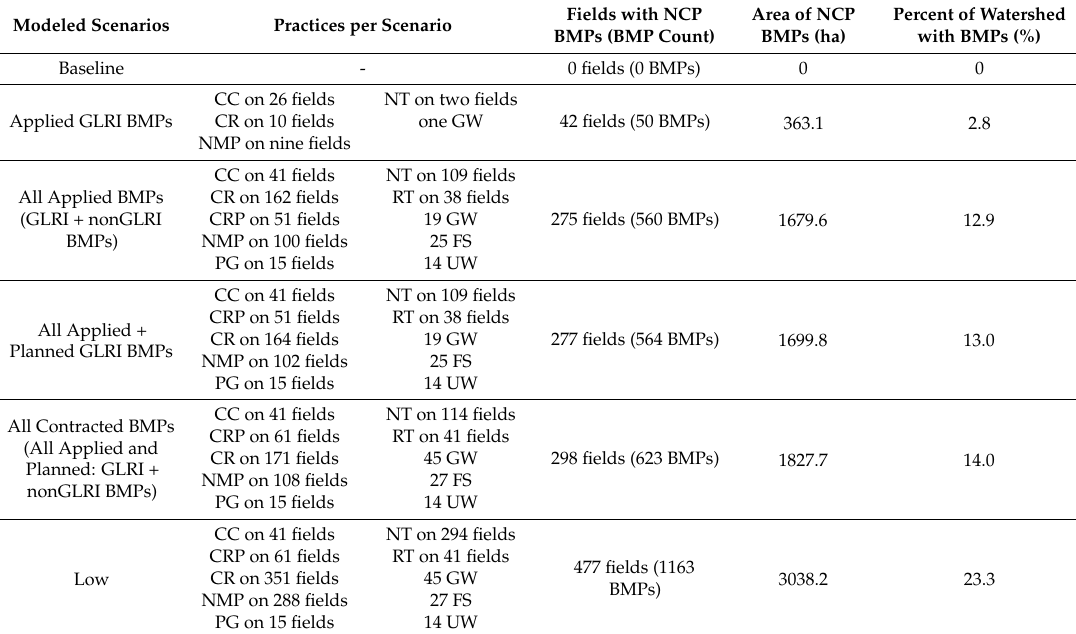
Table 4. BMP implementation scenarios investigated with the Eagle Creek watershed SWAT model,